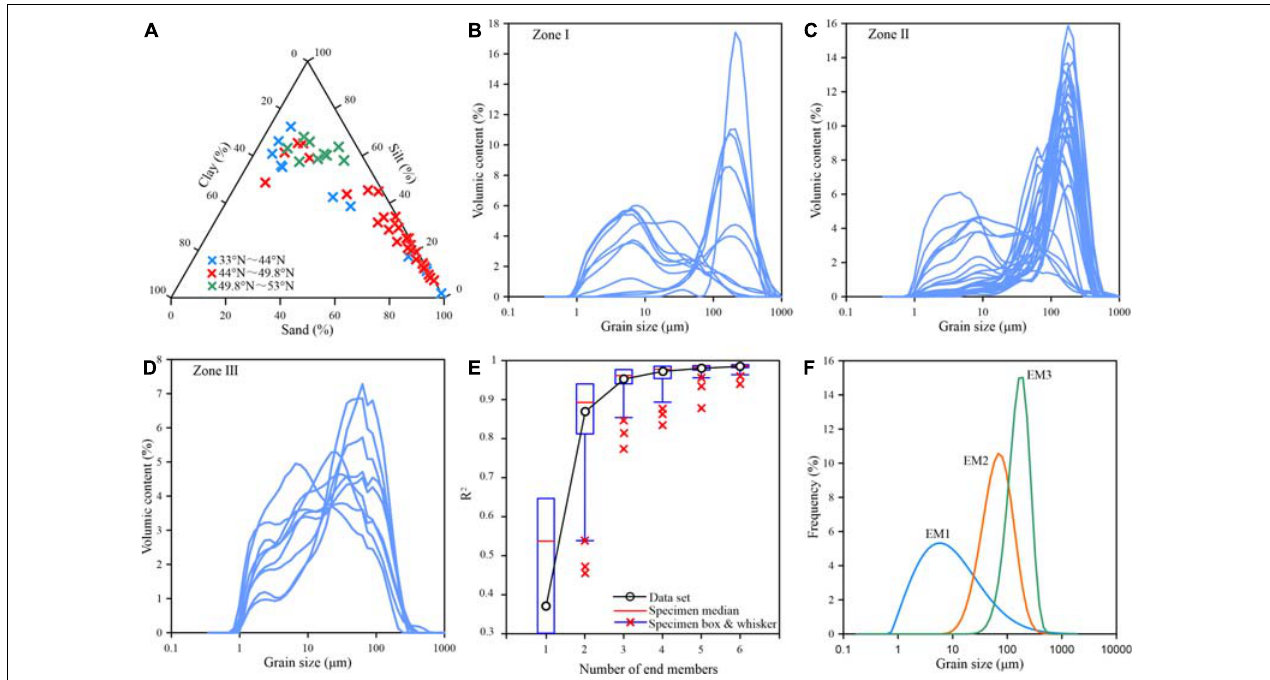
FIGURE 2 | The distribution diagrams of parameters related to grain size of surface sediments. The triangular diagram of grain size (A) , the distribution curves of grain size-volumic content (B–D) , the graph of linear correlation of end members (E) , and the distribution curves of grain size-frequency of modeled end members (F) .